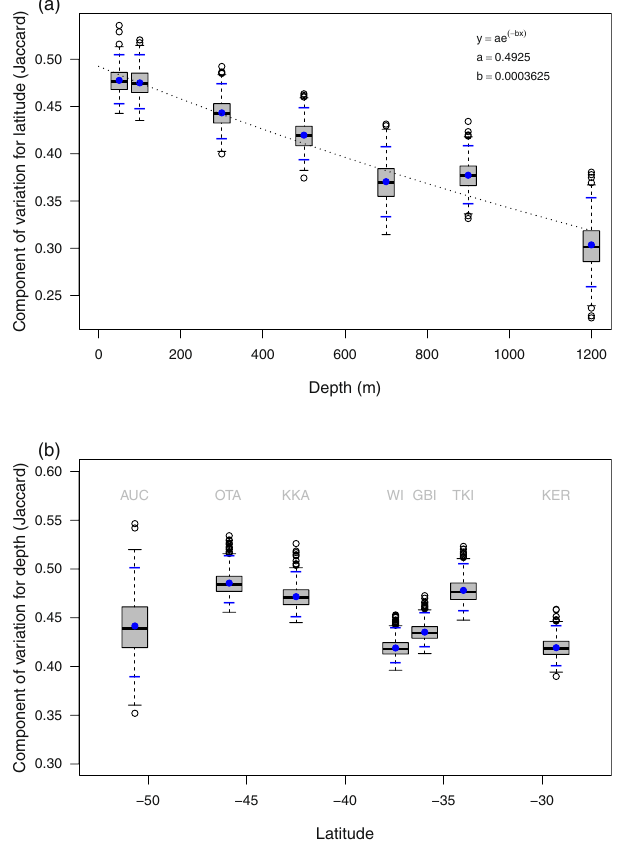
Figure 3. Large-scale beta diversity of fishes versus depth and latitude. Relationship between ( a ) component of variation within each depth stratum (a surrogate for latitudinal beta diversity) vs depth; and ( b ) component of variation within each location (vertical beta diversity) vs latitude, based on square-root-transformed pseudo multivariate components of variation calculated from a PERMANOVA partitioning of Jaccard dissimilarities (blue dots). Box plots in grey show distributions of values from 1000 bias-corrected separate-sample bootstraps of residuals. Blue dashes show 95% confidence intervals based on the 0.025 and 0.975 quantiles of the bias- corrected bootstrap distributions. The dotted line in ( a ) shows the e xponential model of the decay in latitudinal beta diversity vs